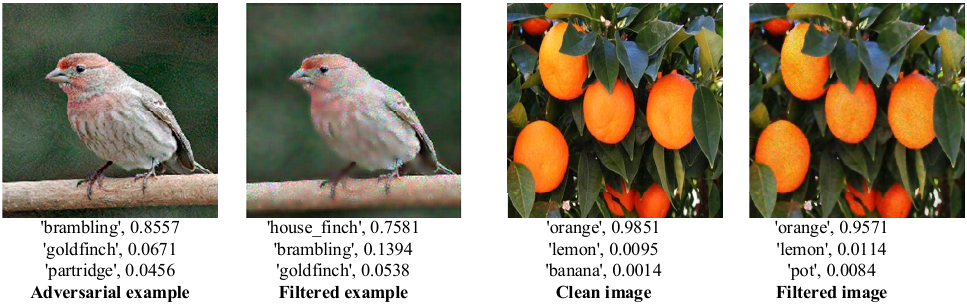
Figure 6. The effect of adaptive wiener filter on clean image and adversarial example.